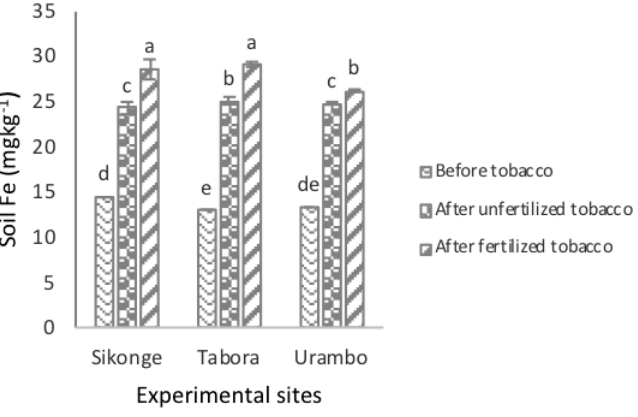
Figure 3. The effect of tobacco and NPK + CAN fertilization on the extractable Fe in soils.